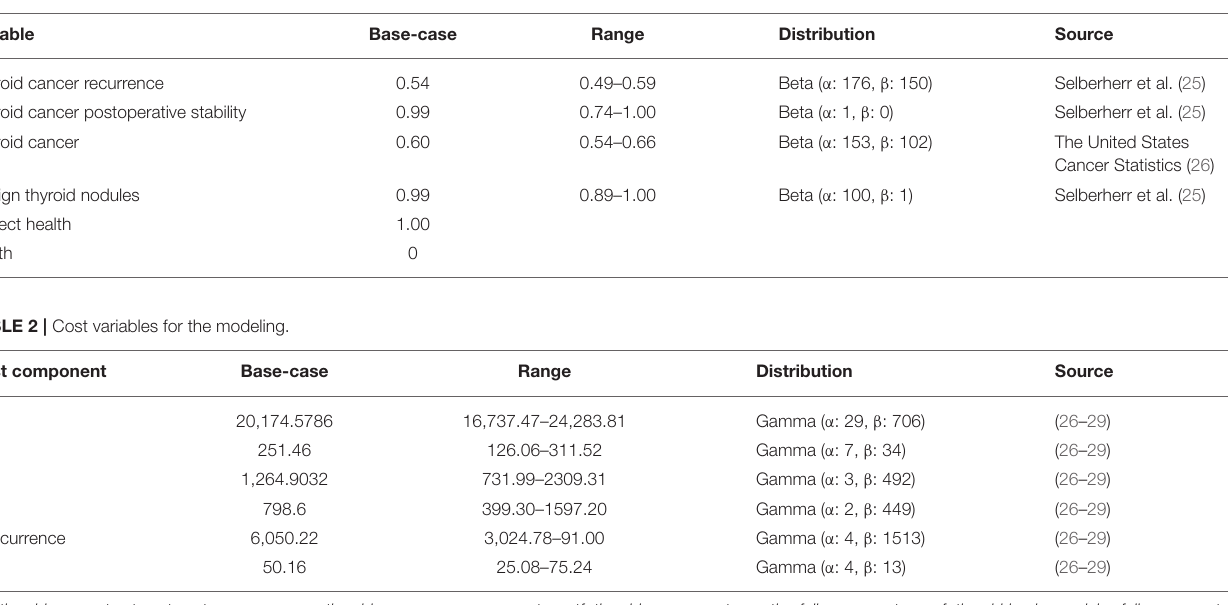
TABLE 1 | Health utility values and associated model variables.